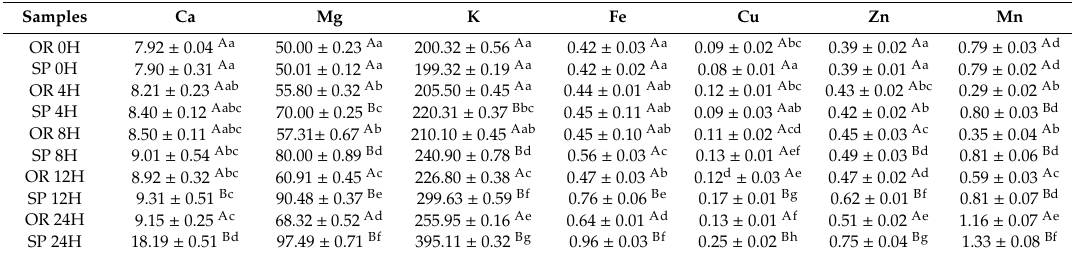
Table 3. Minerals (mg / 100 g f.w.) amount during OR and SP fermentation *. Samples Ca Mg K Fe Cu Zn Mn OR 0H 7.92 ± 0.04 Aa 50.00 ± 0.23